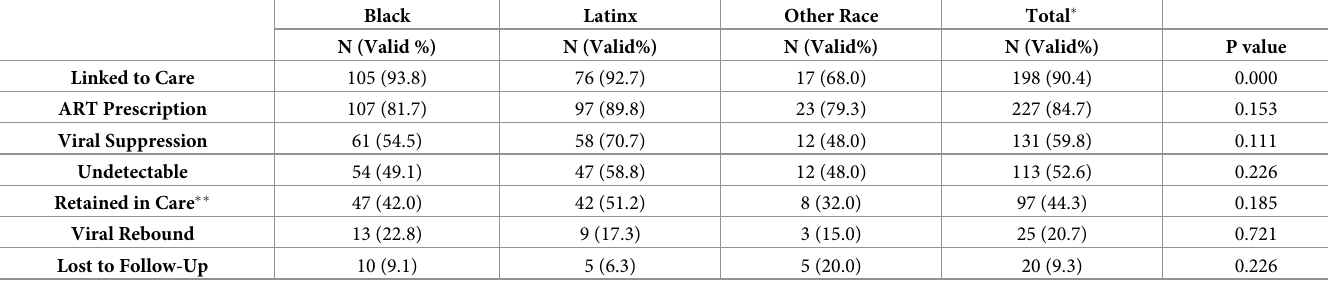
Table 3. HIV care continuum outcomes of newly diagnosed HIV-positive clients in 2016–2020 by race/ethnicity, excluding white (N = 281).